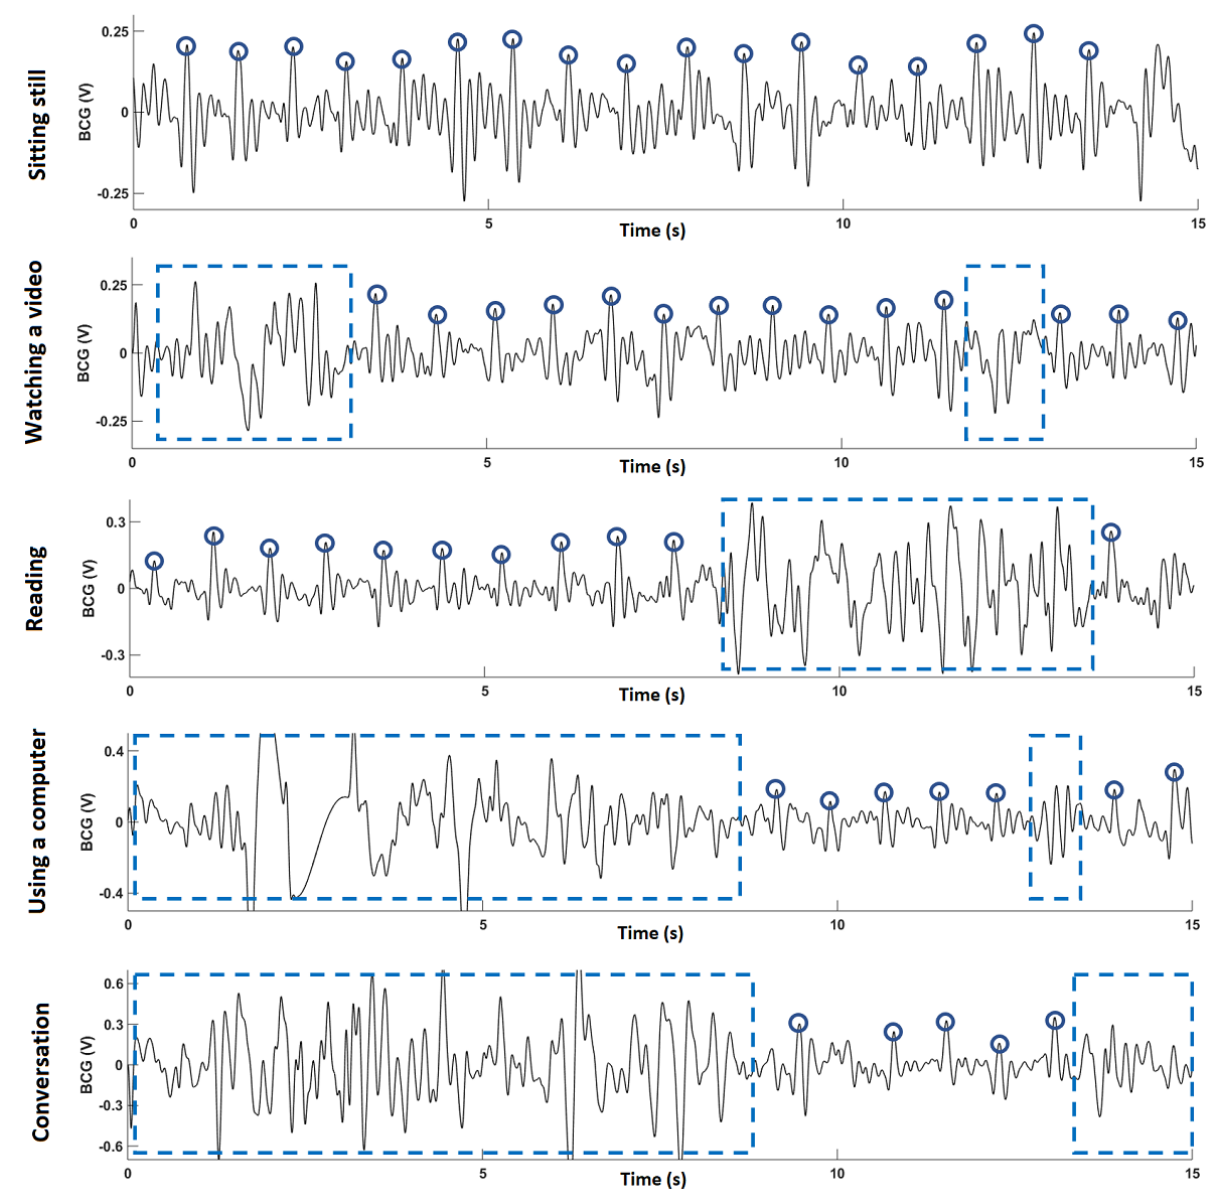
Figure 6. Example data obtained from participant 1 for all five activities. Circles mark J-peaks in the ballistocardiography. Dotted boxes mark noisy signal segments due to motion artifact. BCG: ballistocardiography.